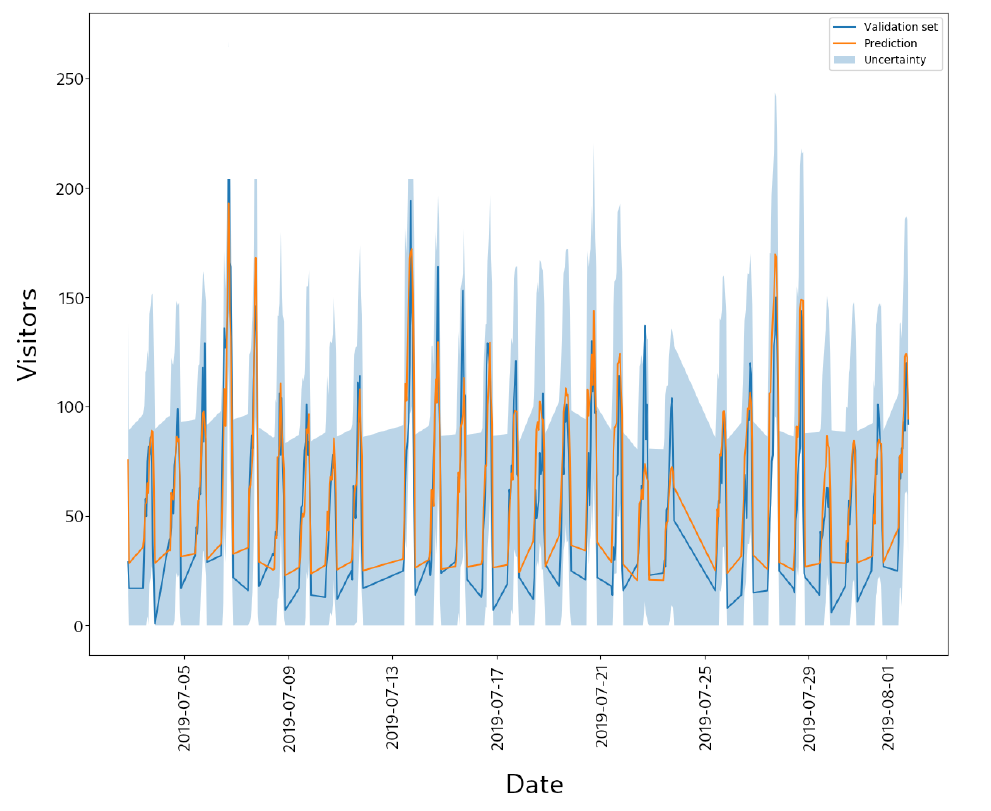
Figure 3. Store visitors